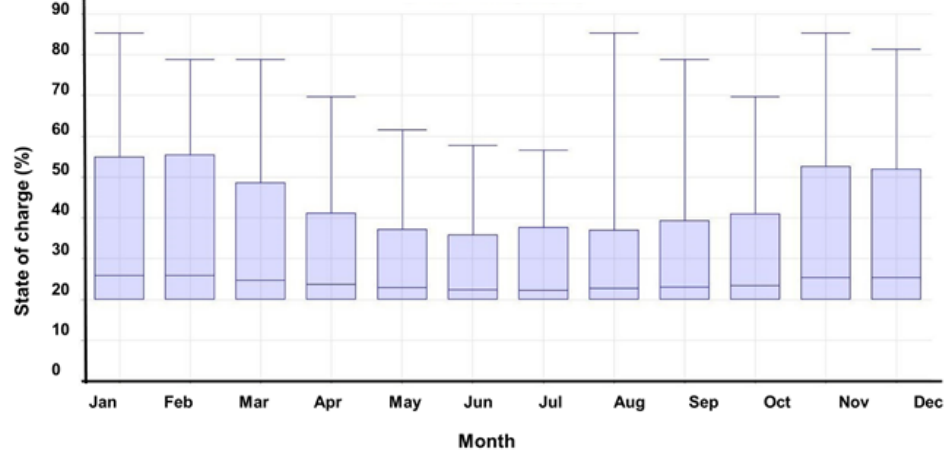
Figure 10. The monthly average SOC of the battery.